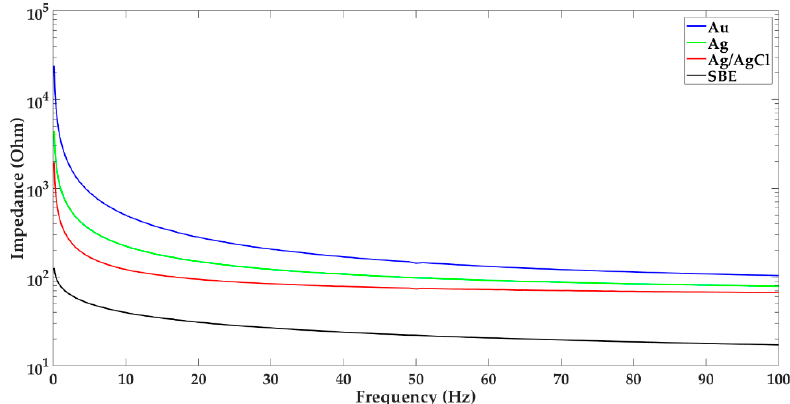
Figure 2. Impedance characteristic of the following new electrodes: gold (Au), silver (Ag), silver/silver chloride (Ag/AgCl), and sintered bridge electrode with gold pin.